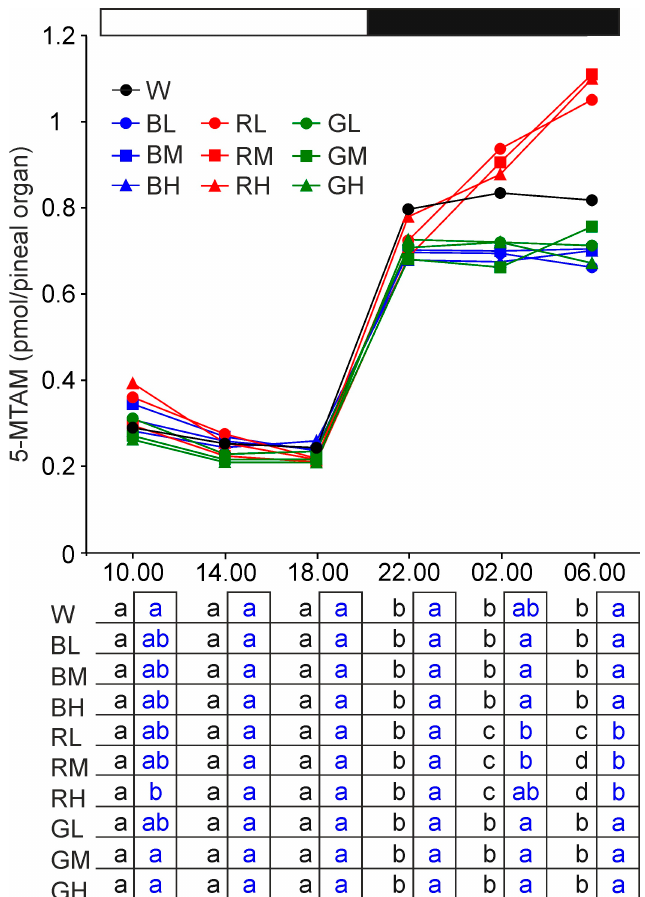
Figure 5. Content (means) of 5-metoxytryptamine (5-MTAM) in the pineal organs of turkeys kept under white light (W) with intensity of 16 lx, blue light with intensities of 16 lx (BL), 32 lx (BM), and 64 lx (BH), red light with intensities of 16 lx (RL), 32 lx (RM), and 64 lx (RH), green light with intensities of 16 lx (GL), 32 lx (GM), and 64 lx (GH) during the photophase. For further explanation, see Figure 1.